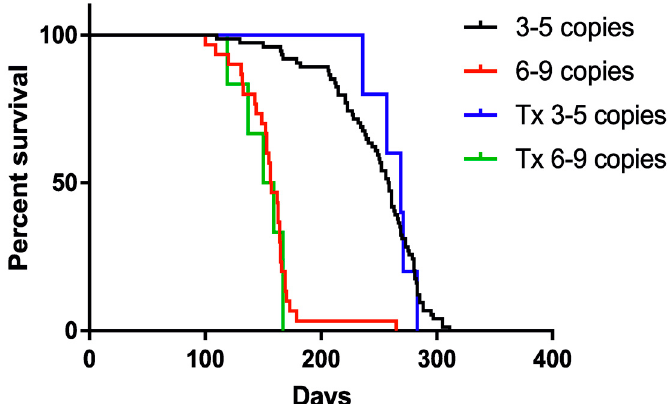
Figure 3. Kaplan–Meier curve presenting the lifespan of transplanted and nontransplanted animals. Sample size within the SOD1/rag2 nontransplanted groups: n = 74 (3–5 copies), n = 30 (6–9 copies), and within the SOD1/rag2 transplanted groups: n = 5 (3–5 copies), n = 6 (6–9 copies); p -value < 0.0001 (log-rank Mantel–Cox